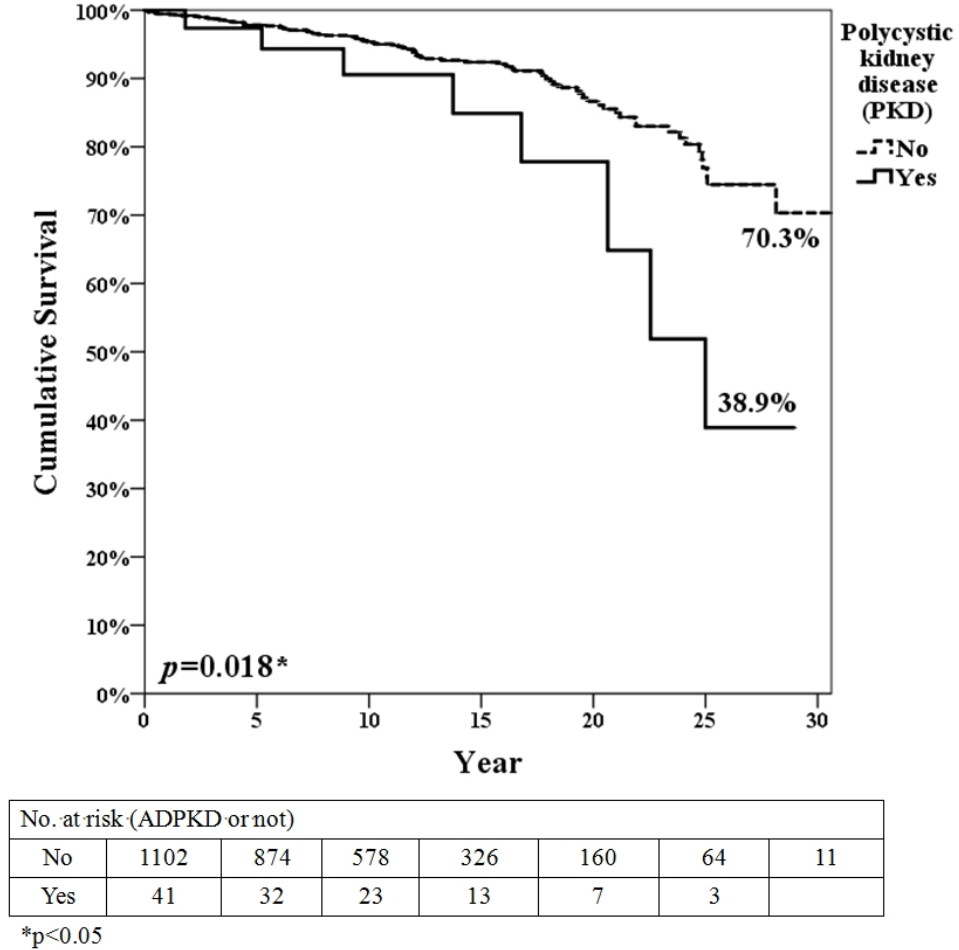
Figure 2. Patient survivals of RTx due to underlying ADPKD or not. The cause of patient mortality in both groups are shown in Supplementary Table S1. Most deaths in both groups were attributable to cardiovascular disease (50% in ADPKD group and 47.1% in non-ADPKD group). In the ADPKD group, other recipients died due to cancer (25%) and infection (12%). In the non-ADPKD group, other recipients died due to infection (26%) and cancer (15.3%). Detailed information of types of malignancy were presented in Supplementary Table S2. In the ADPKD group, most recipients had colon cancer, lung, urinary bladder, and renal cancers. In the non-ADPKD group, most recipients had colon and liver